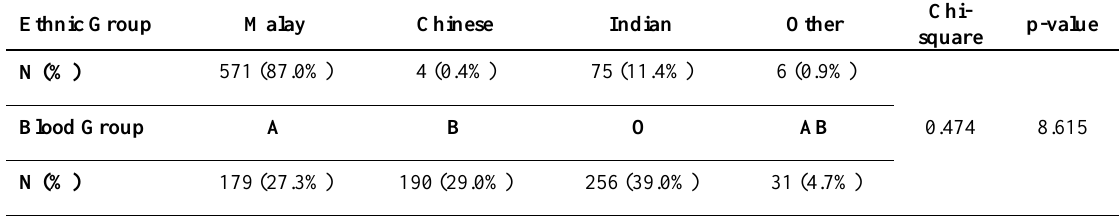
Table 1: Distribution of ethnic group and blood group of students in UNISEL. No significant relationship was found between the ethnic group and blood group distribution.